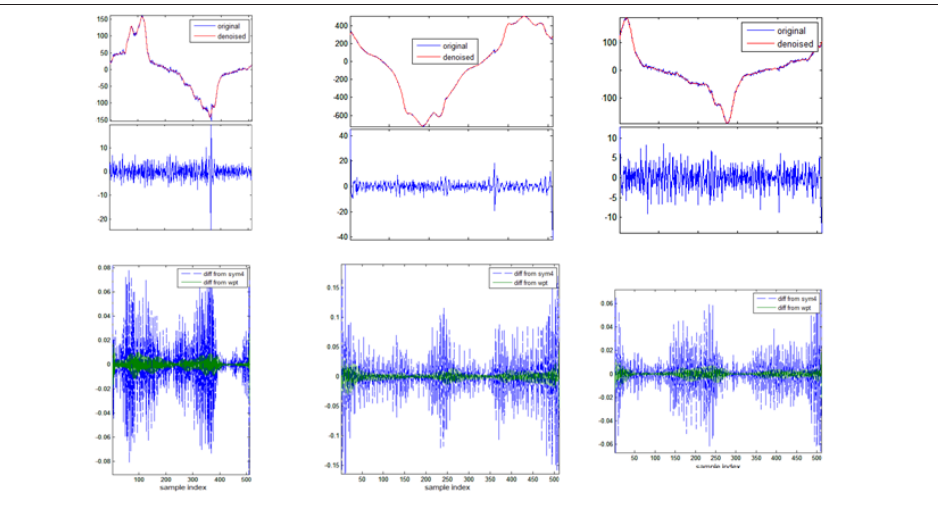
Figure 18. From top to bottom: original and denoised signals; computed noise; di ff erences between computed